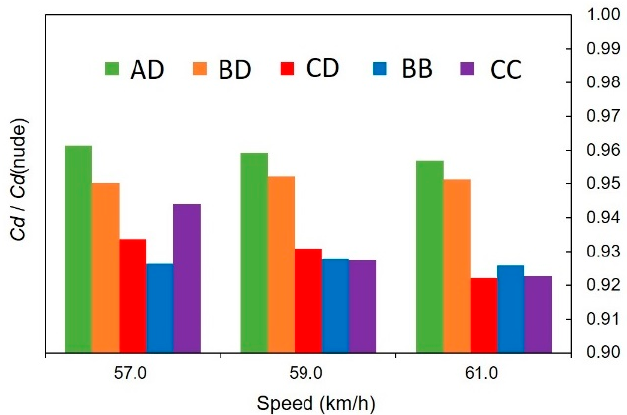
Figure 9. Comparison of drag coefficients of fabrics using the mannequin for bicycles. The number 1.00 on the vertical axis indicates the Cd value when the model is unclothed (nude) and the values in the graph are shown as a ratio with other fabric results.